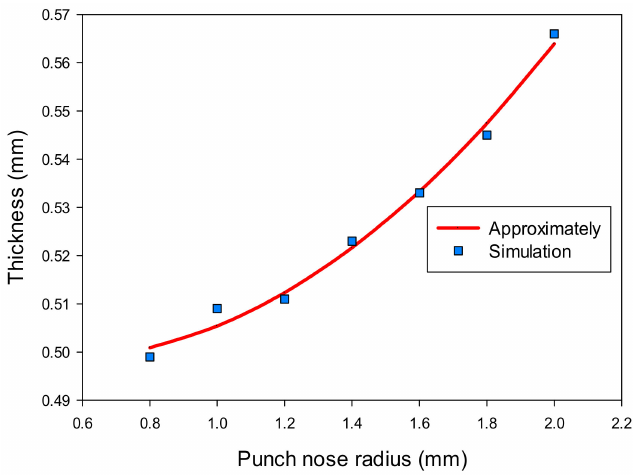
Figure 15. The effect of punch nose radius on thickness.